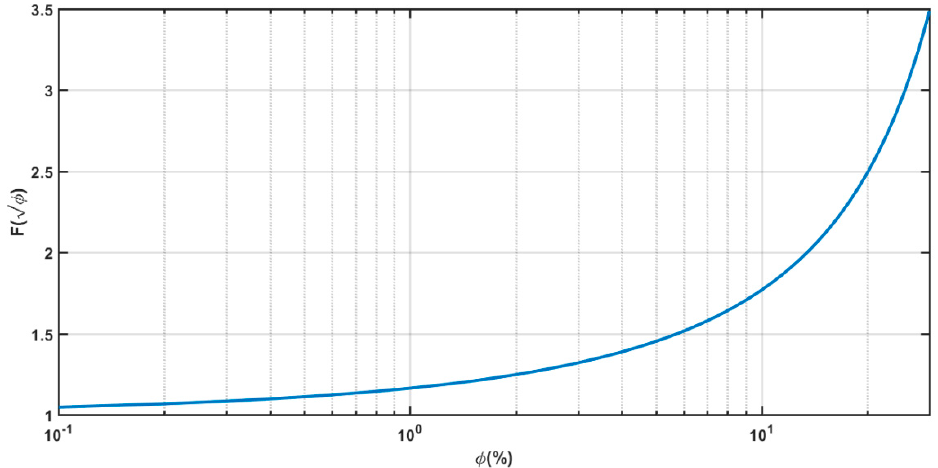
Figure 4. Meaning of b and d in the definition of 𝜖 for the Fok function.